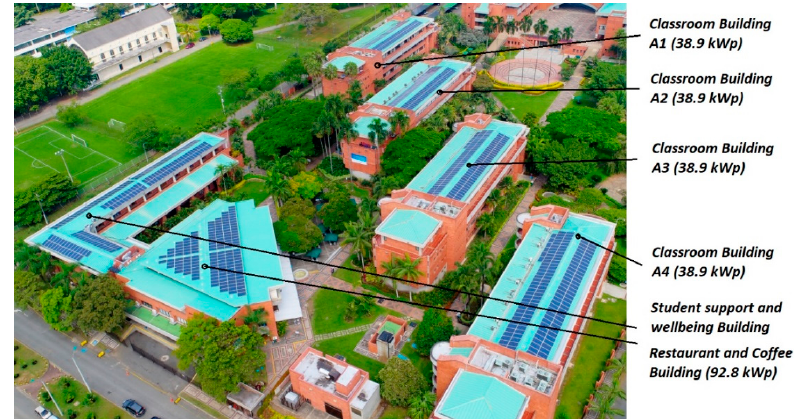
Figure 5. University campus.